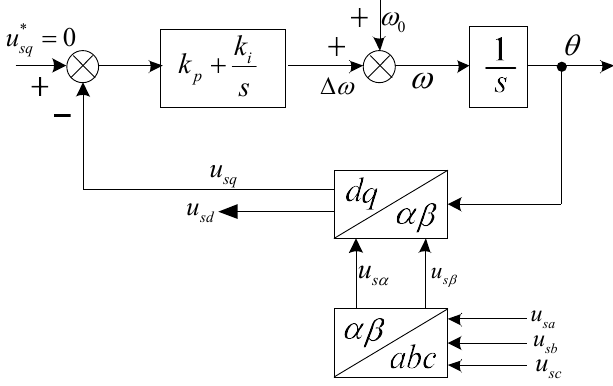
Figure 3. Principle block diagram of SRF-PLL based on control theory.